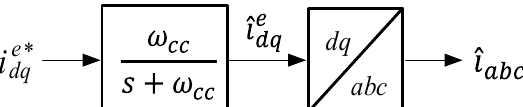
Figure 13. Block diagram of the PI controller and electrical model of the motor system.